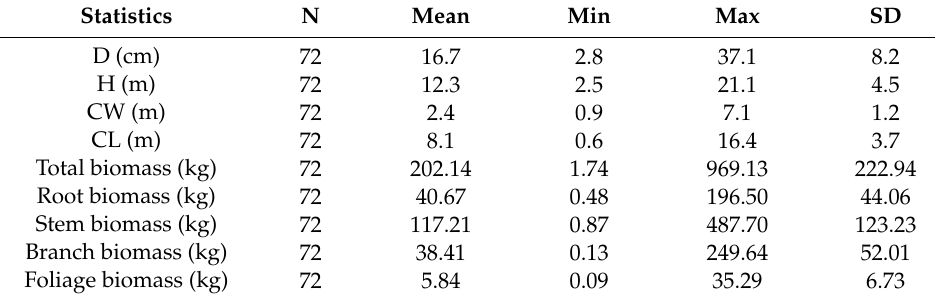
Figure 1. The location of the study area and the distribution of sample plots in Northeast China. Table 1. Descriptive statistics of tree variables. Table 1. Descriptive statistics of tree variables.